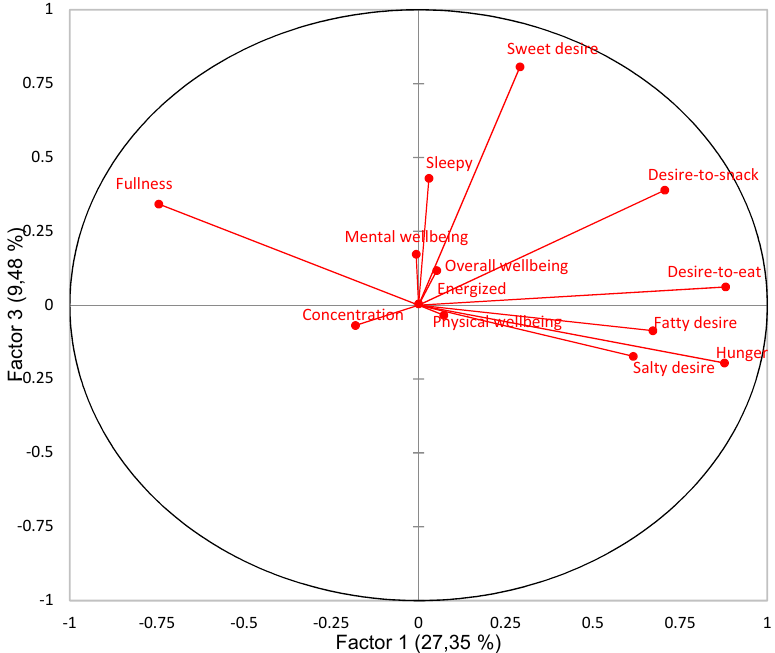
Figure 3. Patterns of correlations for all sensation variables from Principal Component Analysis (PCA)